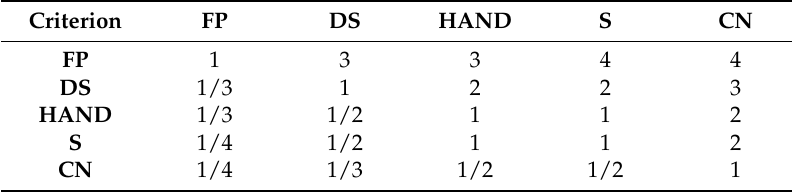
Table A1. Pairwise comparison for flood hazard